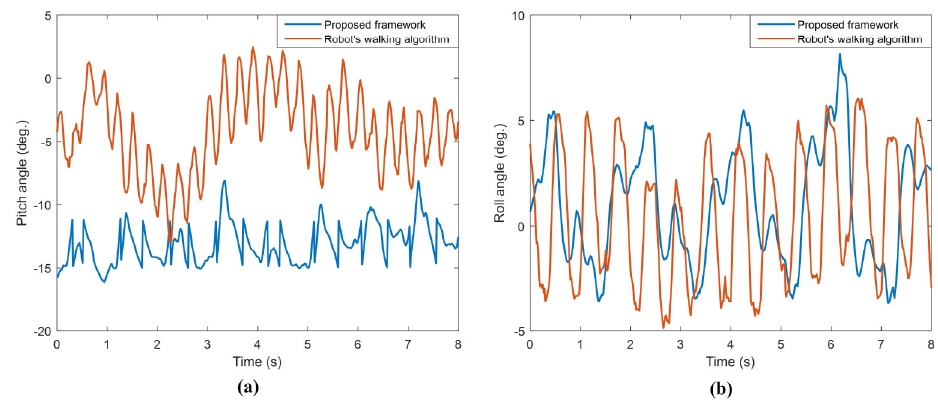
Figure 24. Comparison of orientation angles of real robot during walking: ( a ) pitch angle, ( b ) roll angle.